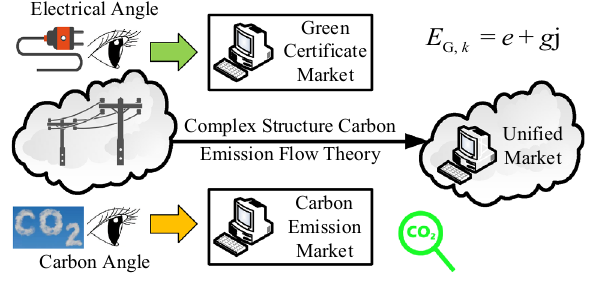
Figure 4. Practical application of complex structure carbon emission flow